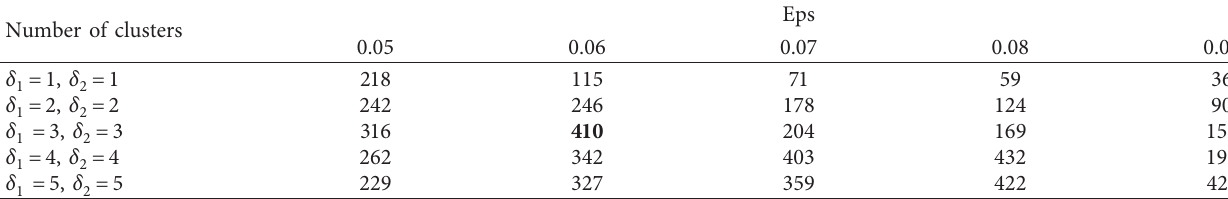
Figure 9: Robust performance of the model ( P � 24, Q � 10, R � 14). Table 4: Parameter selection result.